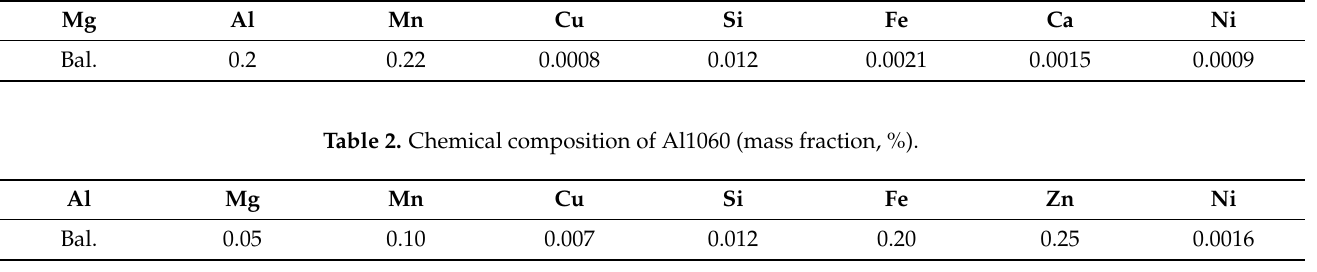
Table 1. Chemical composition of Mg1 (mass fraction, %).